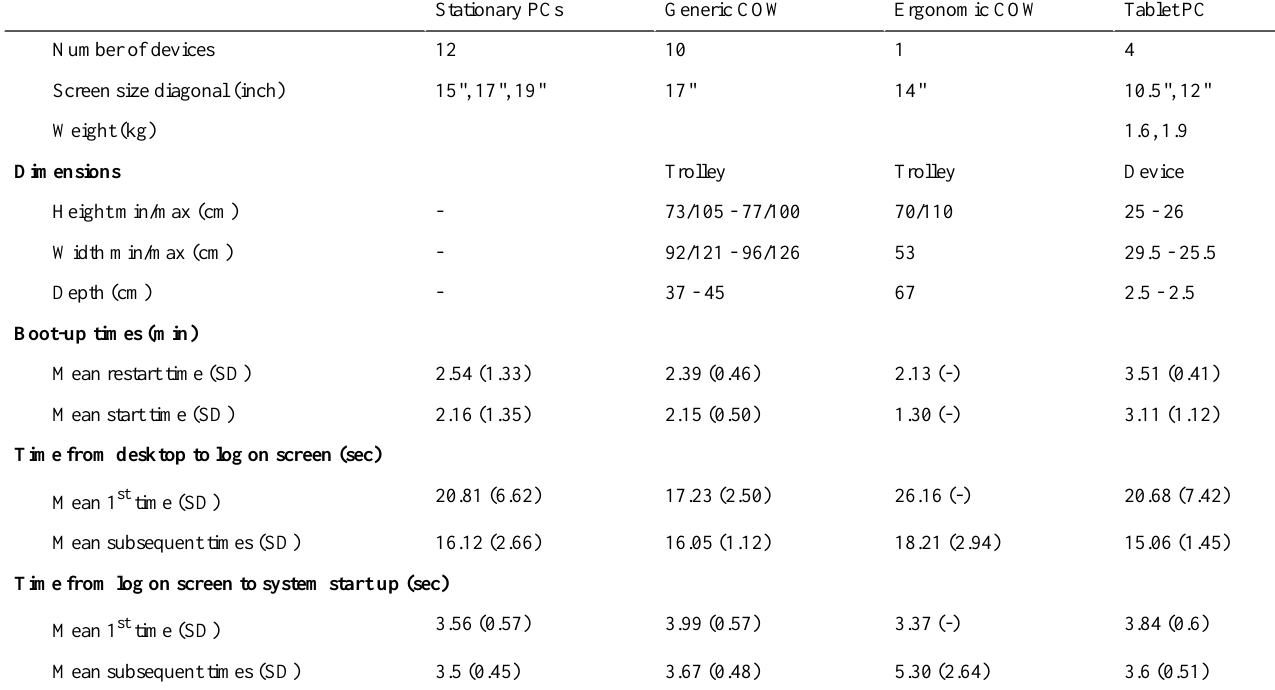
Table 4. Physical attributes of the different